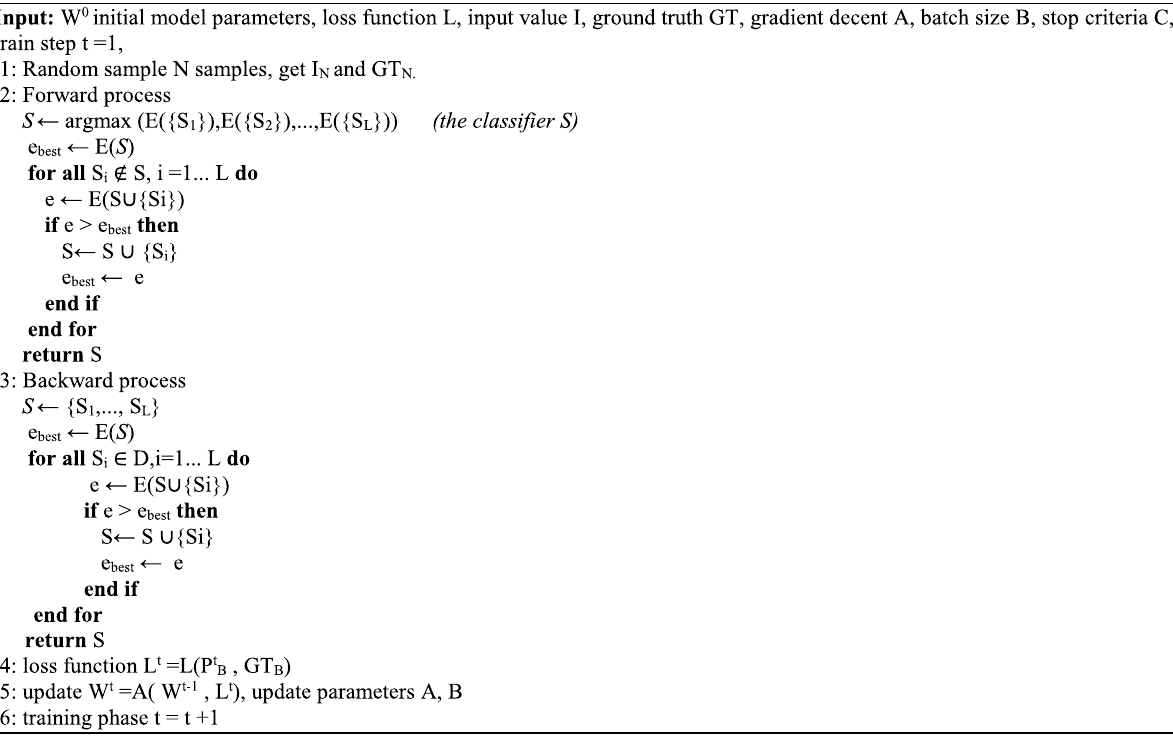
S c represents the summation of input and output of unit c at the final output layer of the fully connected network. I